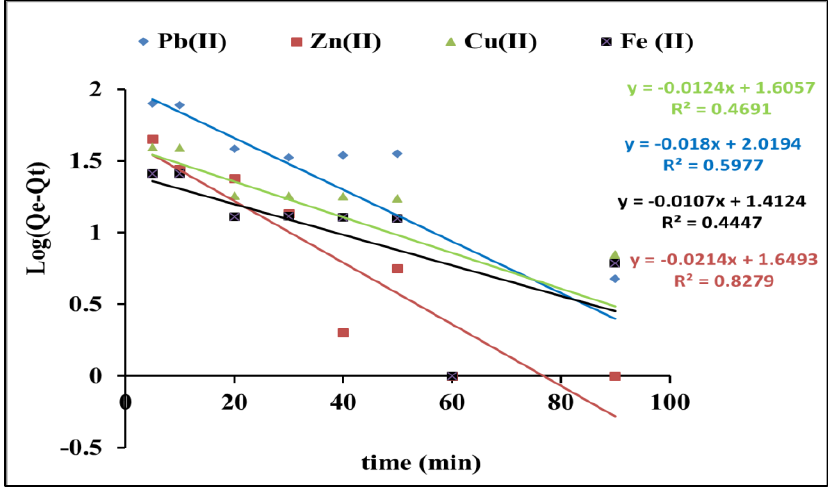
Figure 4. The pseudo-first-order model of the adsorption of Pb(II), Zn(II), Cu(II), and Fe(II) onto RC-MWS, (A) considering time from 0 to 40 min and (B) considering time from 0 to 90 min. The pseudo-second-order kinetic equation, in its integrated form, is expressed as [56]: